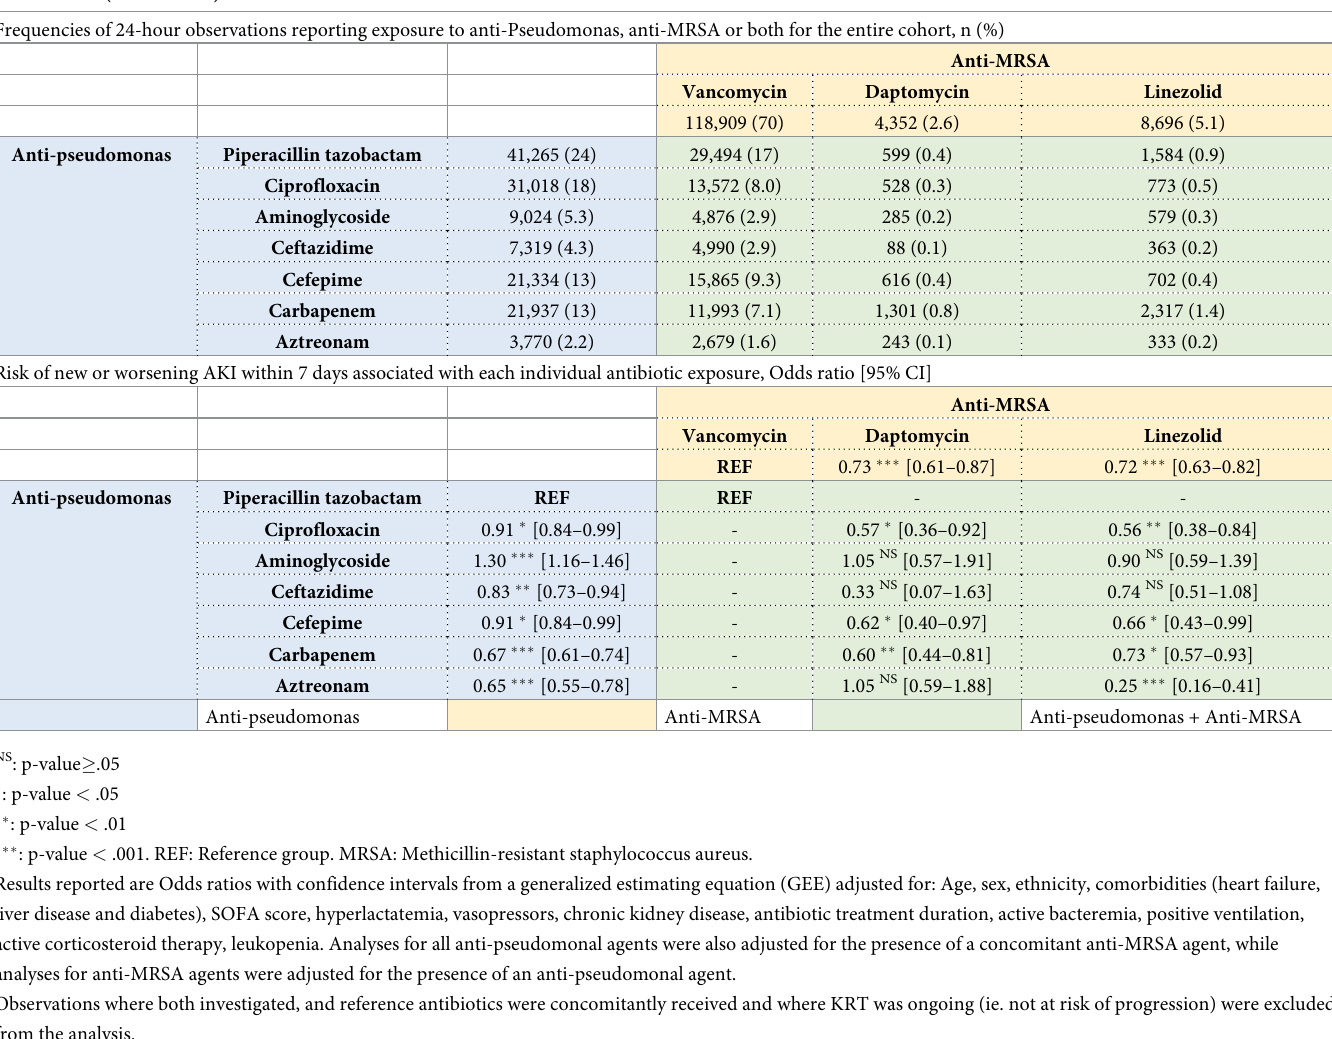
liver disease and diabetes), SOFA score, hyperlactatemia, vasopressors, chronic kidney disease, antibiotic treatment duration, active bacteremia, positive ventilation, active corticosteroid therapy, leukopenia. Analyses for all anti-pseudomonal agents were also adjusted for the presence of a concomitant anti-MRSA agent, while analyses for anti-MRSA agents were adjusted for the presence of an anti-pseudomonal agent. Observations where both investigated, and reference antibiotics were concomitantly received and where KRT was ongoing (ie. not at risk of progression) were excluded from the